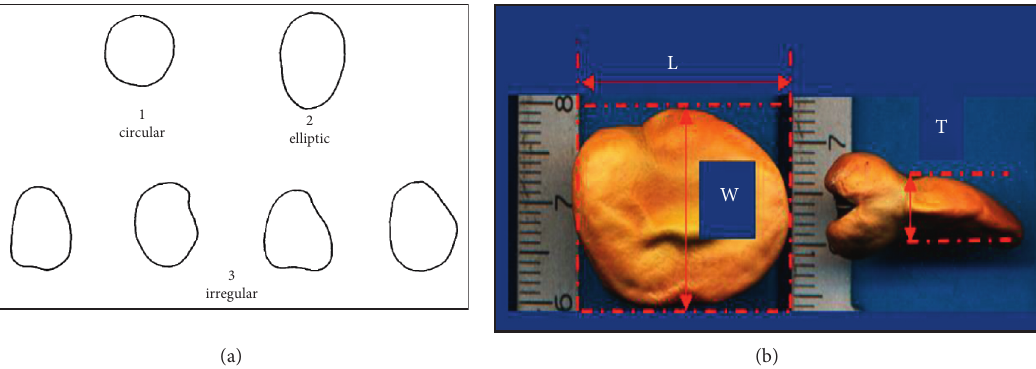
Figure 1: Different shapes and morphophysical parameters of faba bean seeds. L : length, W : width, and T :